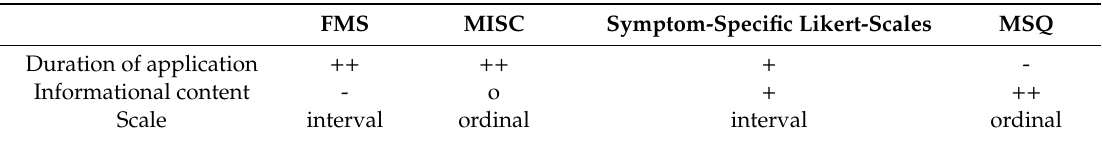
Table 1. Comparison of the four discussed motion sickness assessment tools ( ++ very good; + good; o okay; −